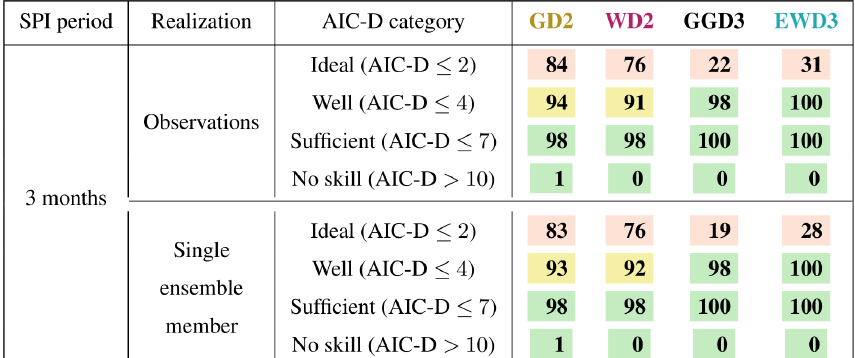
Table 4. Percent of grid points that are classified into specific AIC-D categories (according to Burnham and Anderson, 2002) for each candidate PDF over both seasons. Percentages of grid points indicate the confidence in candidate PDFs to overall performance according to the respective AIC-D category. We consider percentages that exceed (subceed in case of AIC-D values beyond 10) 95% (5%) as a sign of substantial confidence in the candidate PDF (green) to overall performance according to the respective AIC-D category. In contrast, we consider those candidate PDFs that exceed (subceed) in 85% (15%) of the grid points as a sign of average confidence in the candidate PDF (yellow) to overall performance according to the respective AIC-D category. Percentages that fall short of 85% (or that show no skill in more than 15%) are considered as an overall sign of insufficient confidence in the candidate PDF (red). In contrast to Table 3, the evaluation of simulations is based on a single ensemble member. Observations are identical to Table